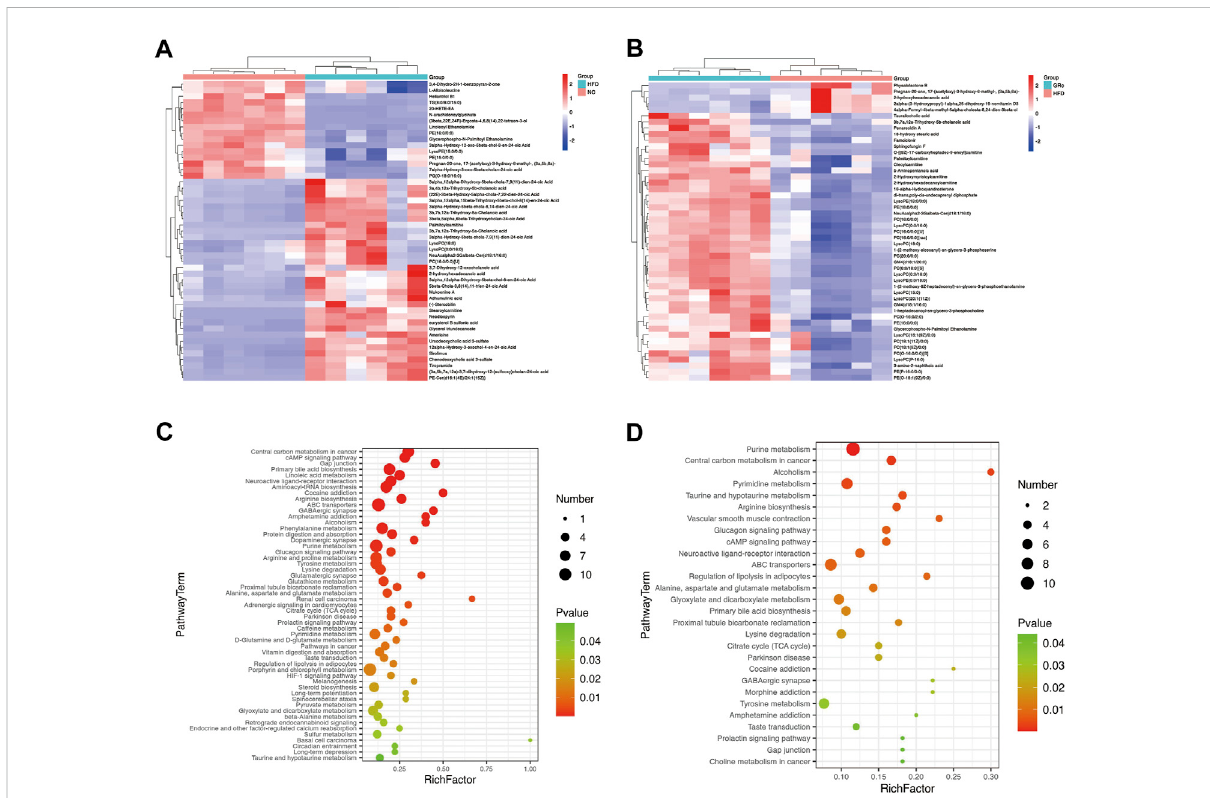
FIGURE 8 GRcregulated themetabolic pathwaysinApoE − / − mice( n =6). (A) Clustering heatmap ofdifferential metabolites infecesbetweenHFDandNC groups. (B) Clustering heatmap of differential metabolites in feces between GRc and HFD groups. (C) KEGG pathway enrichment scatterplot between HFD and NC groups. (D) KEGG pathway enrichment scatterplot between GRc and HFD groups. Rich factor indicates the number of differentially expressed metabolites located in the KEGG/the total number of metabolites located in the KEGG (NC, normal control; HFD, high- fat diet; GRc, ginsenoside Rc).